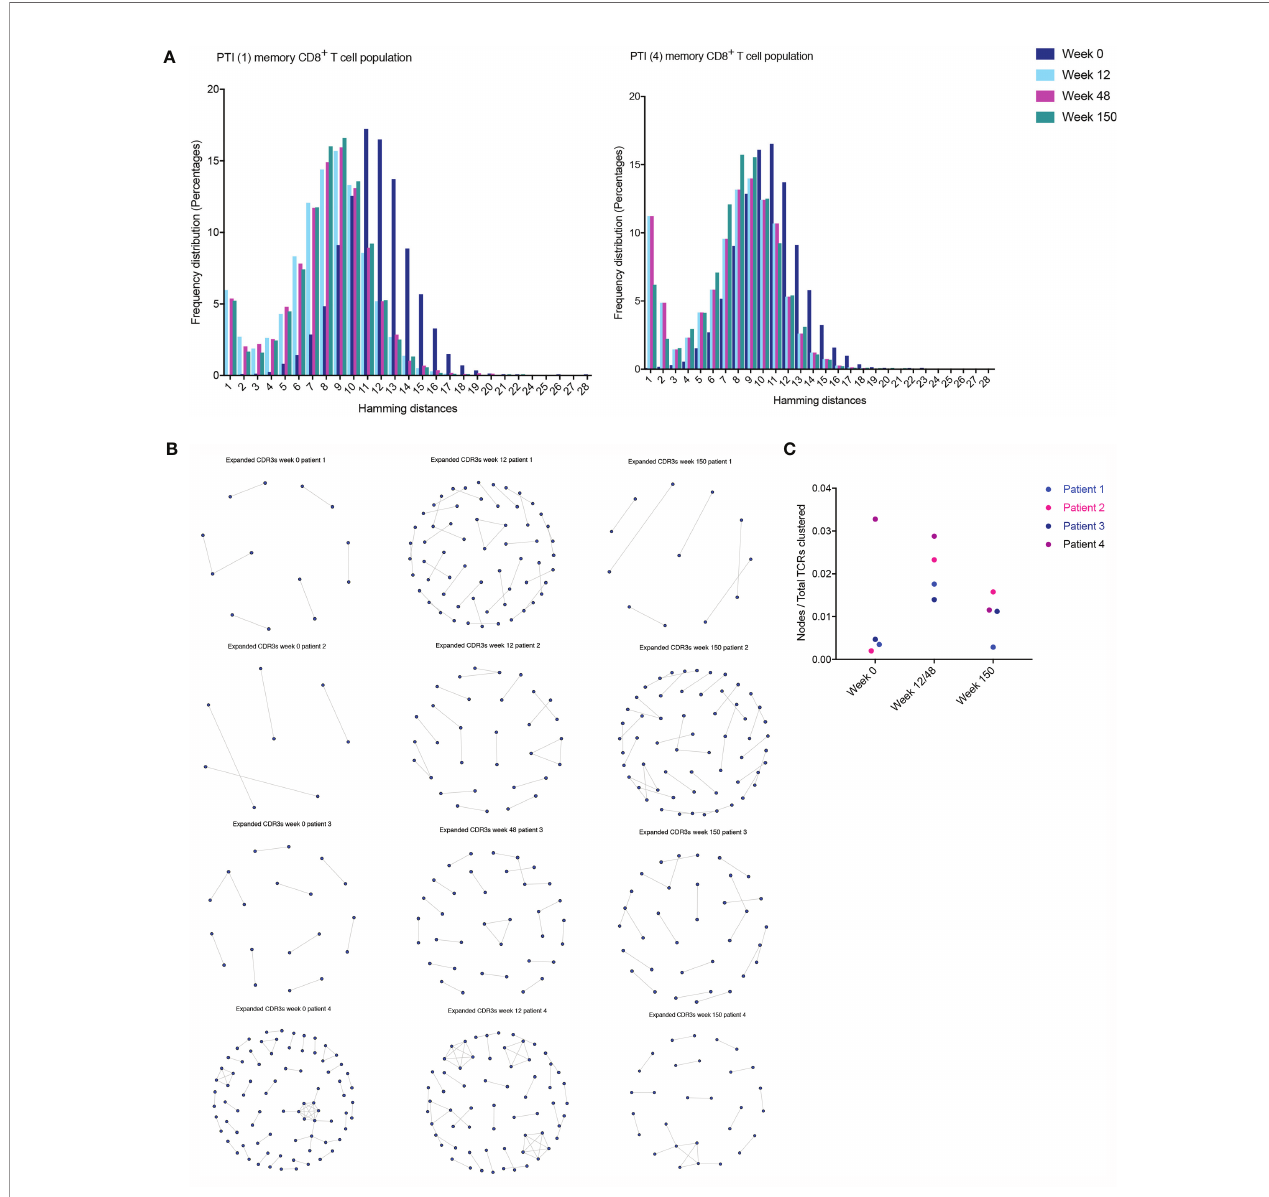
FIGURE 5 | T cell clustering following ART interruption. TCR CDR3 sequence similarities were computed using the Hamming distance to tests two pairwise CDR3s of equal length at a time creating a CDR3 similarity network. A Hamming distance of 1 re fl ects a single AA change between two neighboring CDR3s. (A) The distribution of pairwise Hamming distances between CDR3s in the memory CD8 + T cell repertoires. (B) TCR CDR3 sequence similarities were also computed using a shared triplet metric of closely related CDR3s forming network clusters in the memory CD8 + T cell population. (C) The number of nodes as a proportion of the number of total TCRs being clustered for each sample following